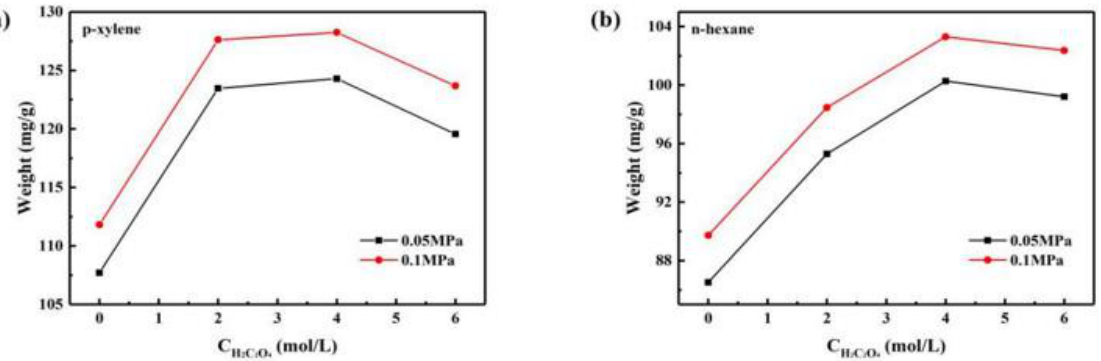
Figure 6. Variation in the adsorption capacities for ( a ) p-xylene and ( b ) n-hexane of samples after H 2 C 2 O 4 treatment. H 2 C 2 O 4 treatment.